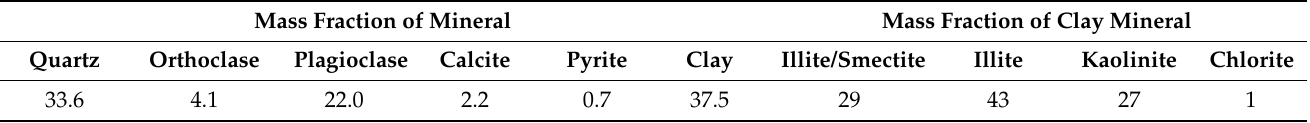
Figure 2. Images of cast body thin section analysis of tight sandstone gas reservoir samples. ( a ) medium-grained rock chips. ( b ) medium-fine-grained rock chips.